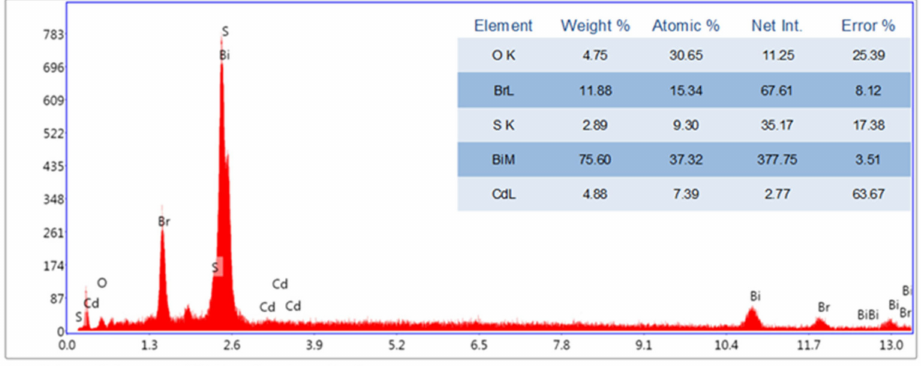
Figure 3. Local EDS results of the BiOBr/Bi 2 S 3 /CdS composite shown in Figure